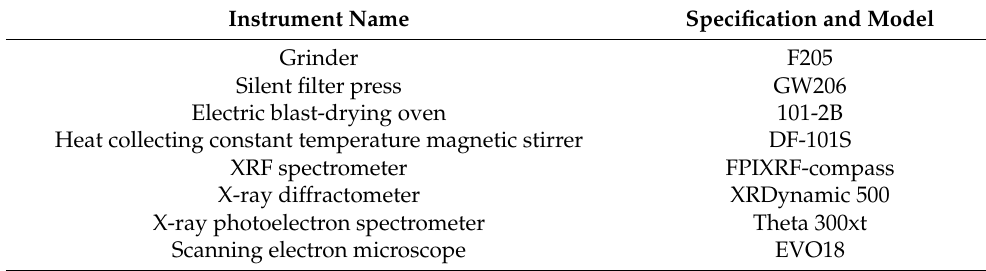
Table 1. Instruments used in the